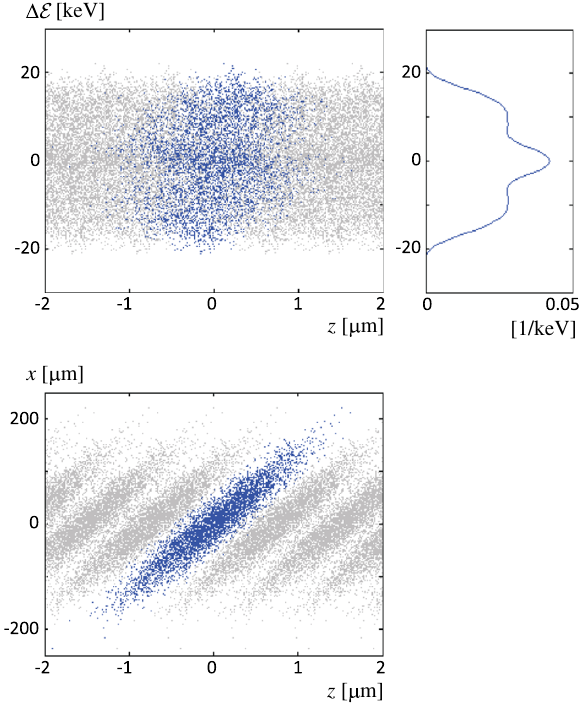
FIG. 20. Application C: longitudinal phase space ð Δ E ; z Þ , top view ð x; z Þ and energy spectrum for the position 15.5 m, near the zero crossing of r 11 .